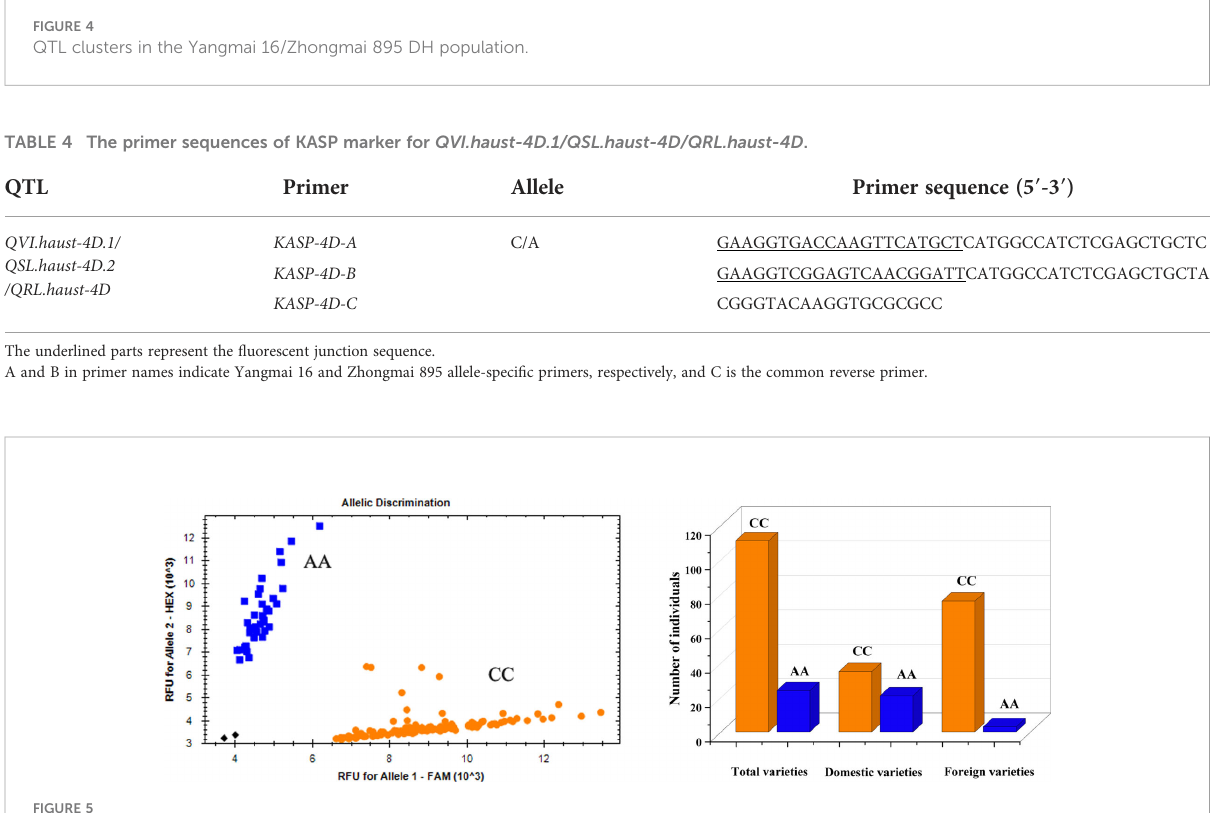
FIGURE 5 Genotype calling screenshots of the KASP marker. Orange indicates the C allele of Yangmai 16, blue indicates the A allele of Zhongmai 895, and black indicates the blank control. The same